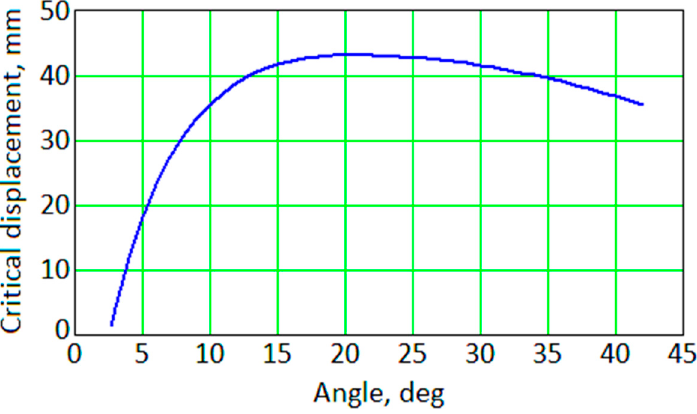
Figure 12. Limitation for the vertical displacement Δ k 2 max [mm] of the carriage for different values of the angle α [deg] when the 2nd clutch is switched-on ( L = 53 mm and z = 2.8 mm).